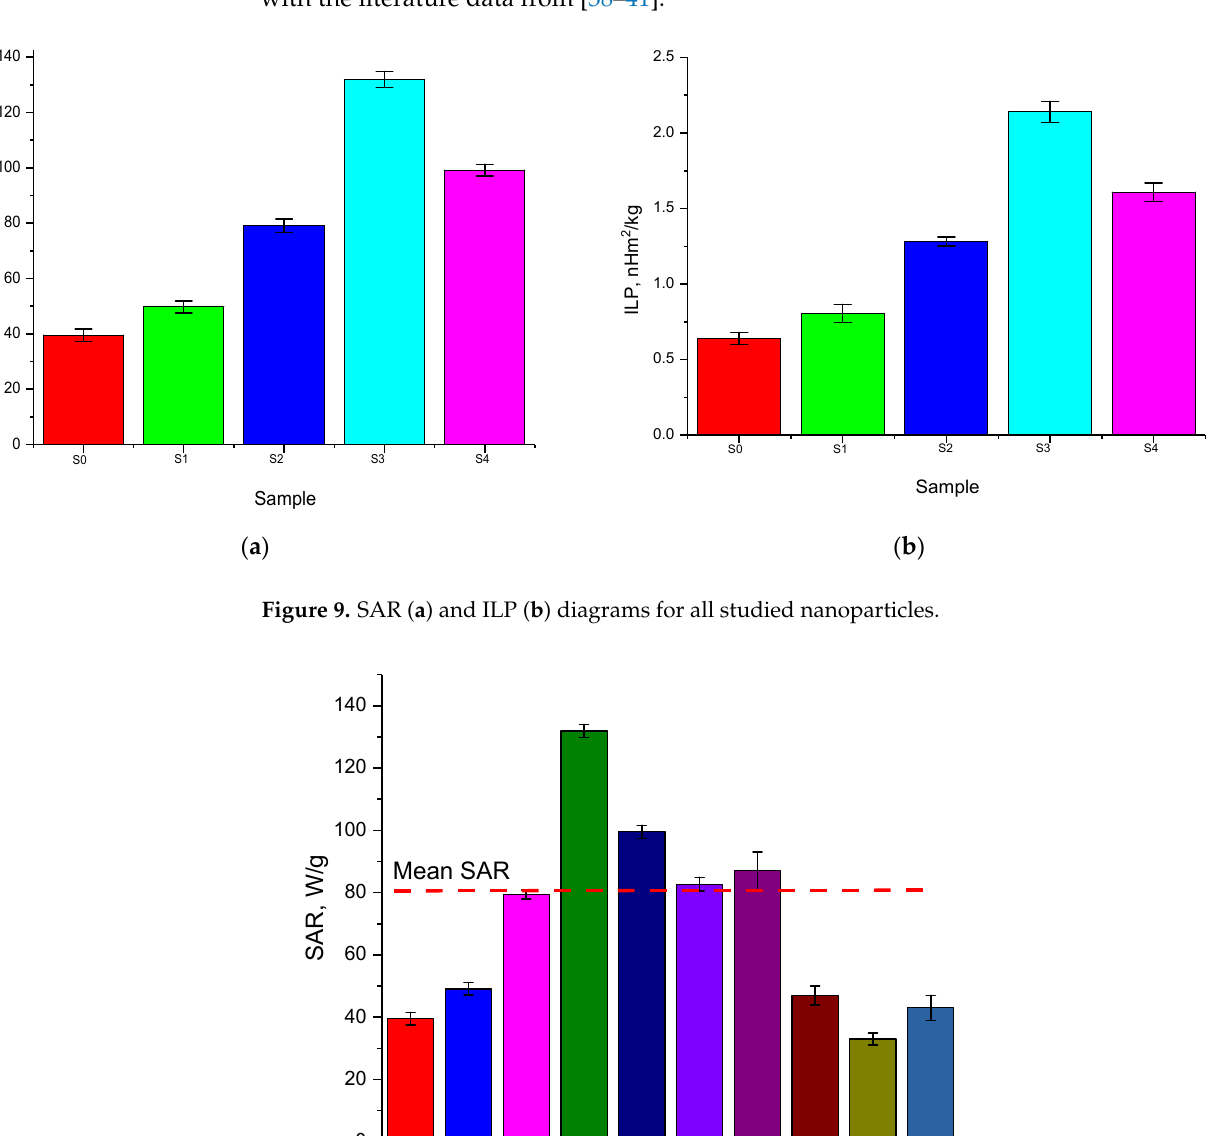
Figure 9. SAR ( a ) and ILP ( b ) diagrams for all studied nanoparticles.